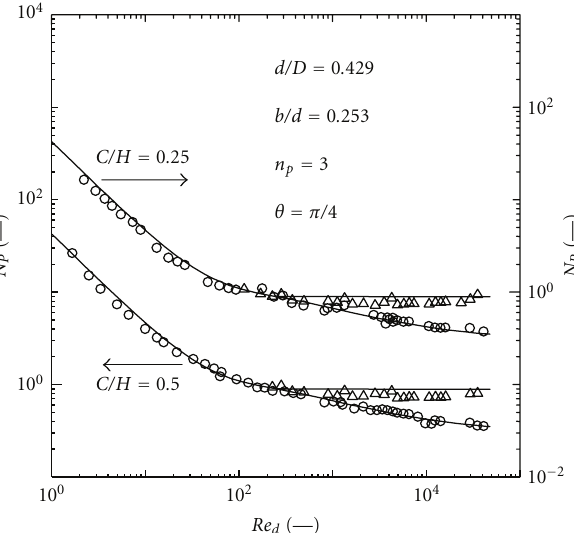
Figure 5: Power diagram of propeller impeller (— calc; (cid:2) N P 0 ; (cid:2) N P ).